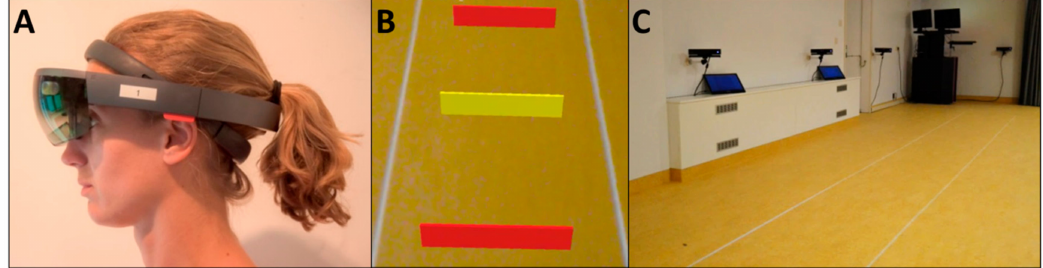
Figure 1. HoloLens 1 ( A ), 3D holographic cues seen through HoloLens 1 ( B ) and Interactive Walkway used as a reference motion-registration system ( C